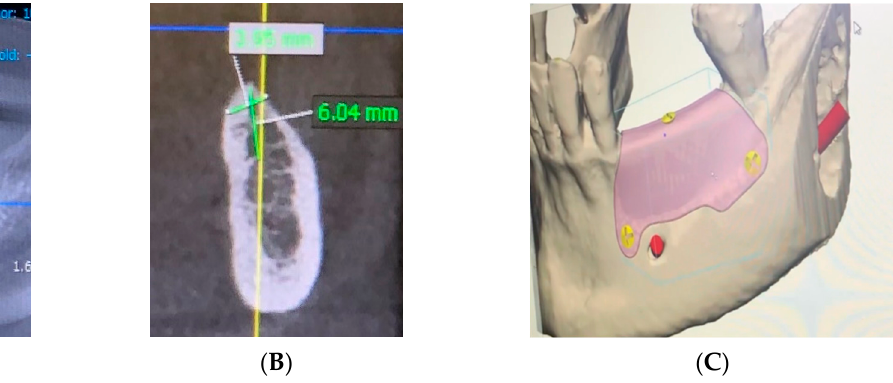
Figure 1. Vertical bone defect in the intraoral examination of the third quadrant.